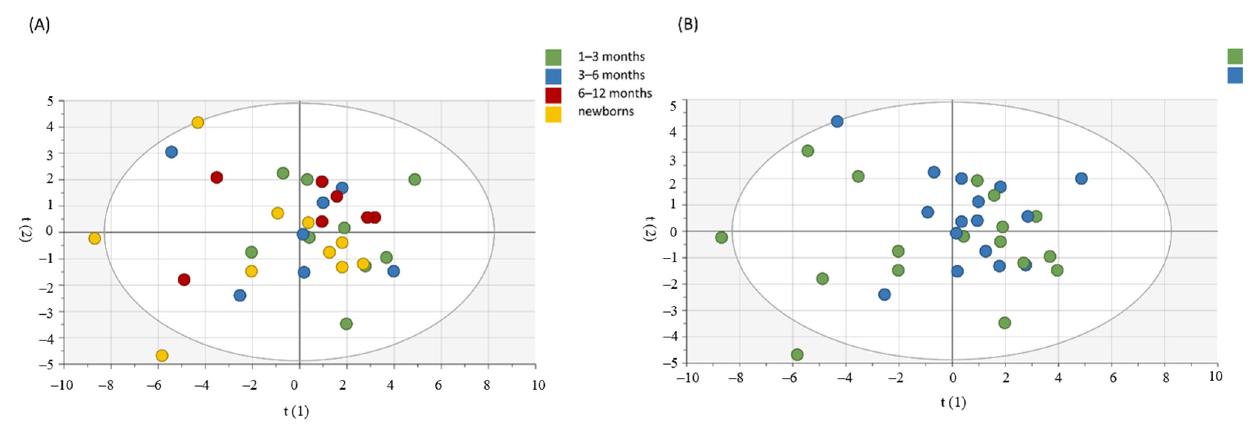
Figure 2. Principal component analysis for the assessment of influence of age ( A ) and gender ( B ) in the circulant levels of inflammatory mediators in children exposed to maternal CHIKV virus infection. The Hotelling ellipse represents the 95% confidence interval for the model.